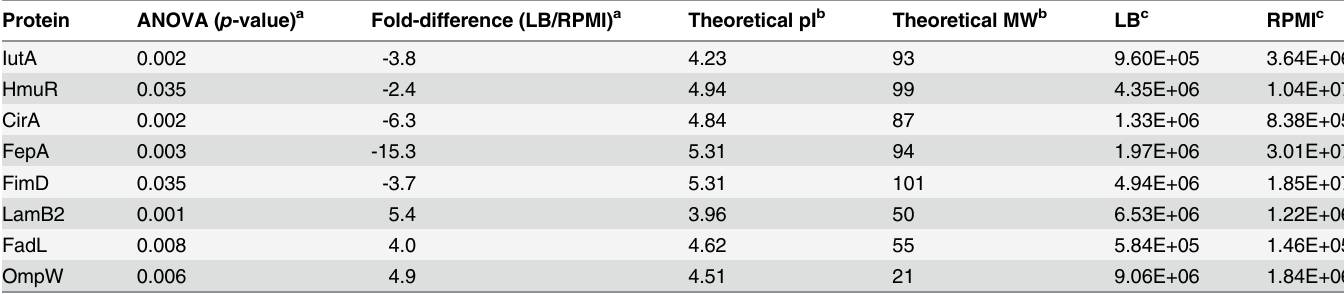
Table 1. Comparison of outer membrane protein abundance in LB and